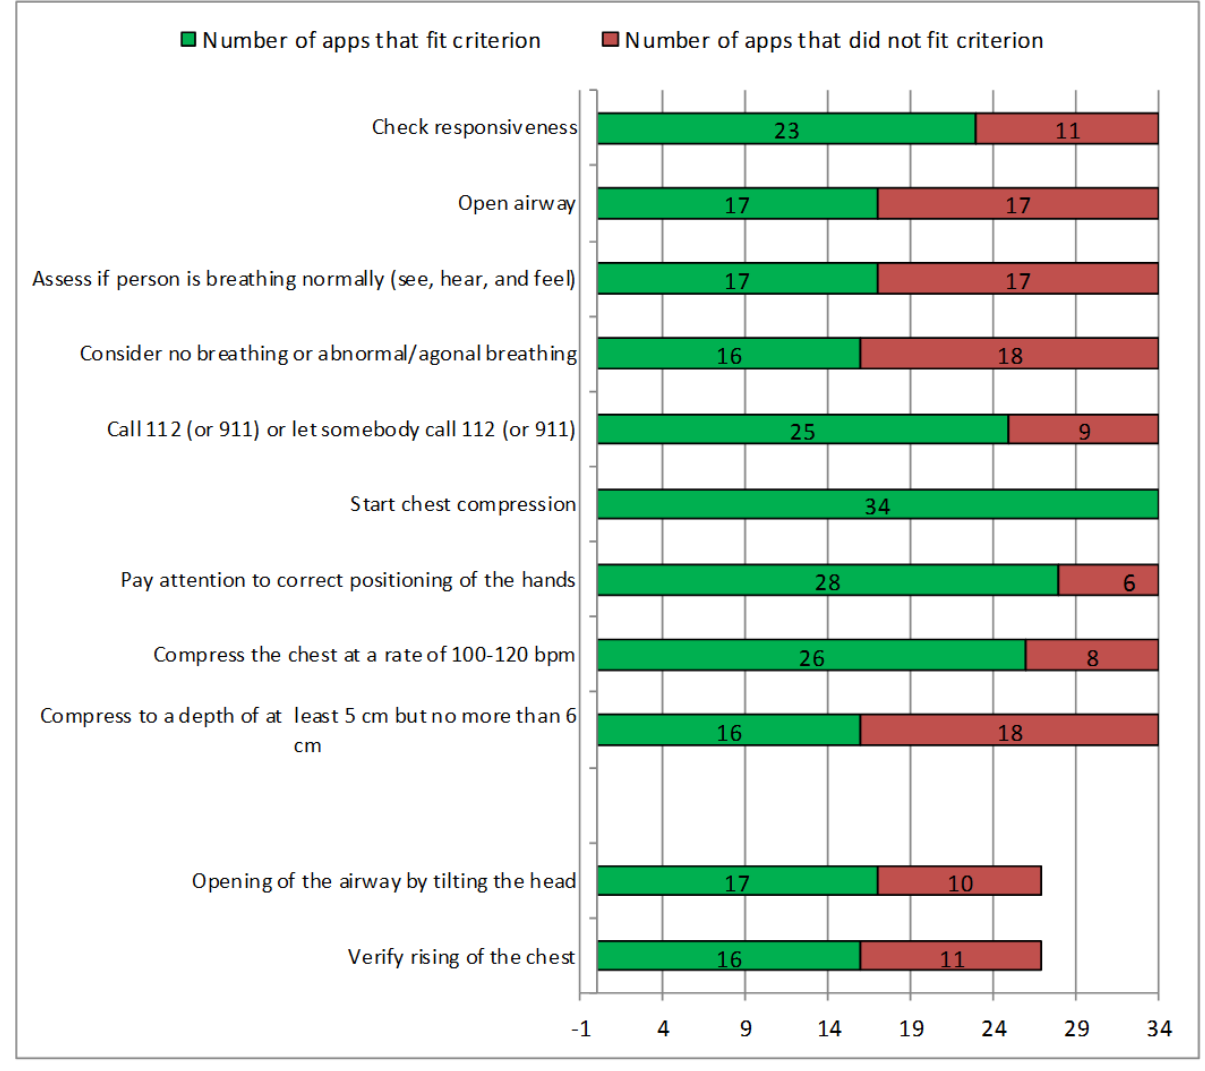
Figure 2. Apps in accordance with the criteria used to evaluate guideline adherence.